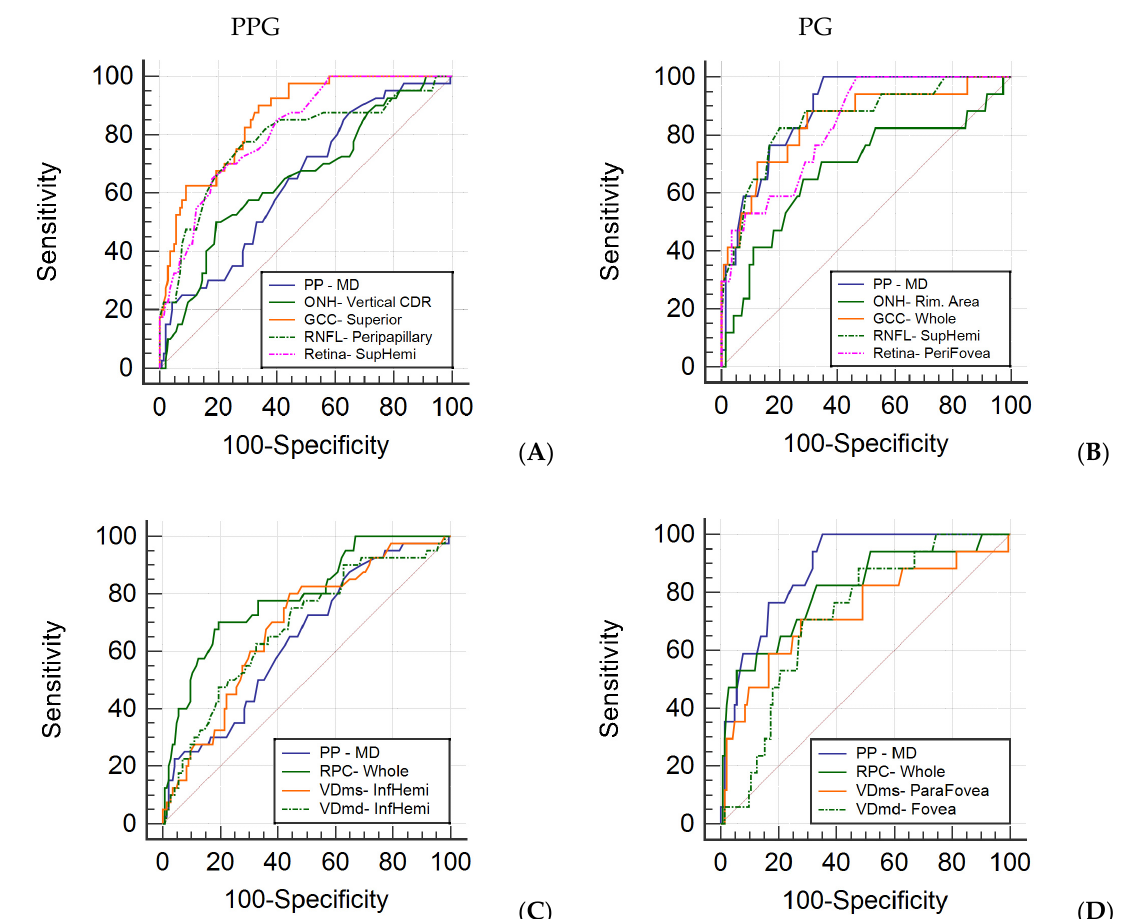
Figure 2. Receiver operating characteristic curve of most sensitive parameters in each category. Area under the curve (AUC) of the most sensitive parameters from Pulsar perimetry and structural parameters of OCT and OCTA in PPG ( A ) and PG ( B ). Area under the curve (AUC) of the most sensitive parameters from Pulsar perimetry and capillary parameters of OCTA in PPG ( C ) and PG ( D ). PP = Pulsar perimetry; MD = mean defect; ONH = optic nerve head; CDR = cup–disc ratio; GCC = ganglion cell complex; RNFL = retinal nerve fiber layer; RPC = radial peripapillary capillary; VDms = vessel density of macular superficial vascular complex; VDmd = vessel density of macular deep vascular complex; SupHemi = superior-hemi; InfHemi = inferior-hemi. Table 5. Correlation matrix of generalized structural and vascular parameters of OCT and OCTA and functional parameters.